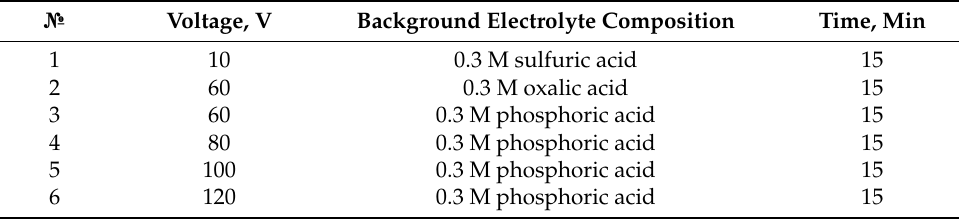
Table 1. Anodized aluminum foil samples preparation.